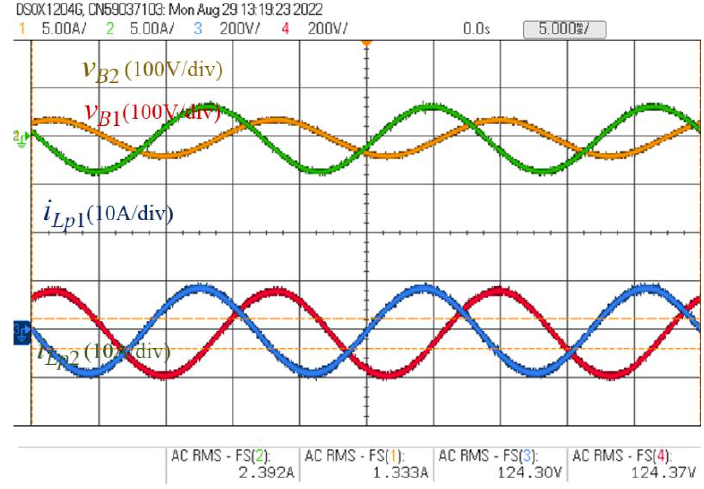
Figure 21. Experimental waveforms of the H-bridge inverter for a three-phase system.